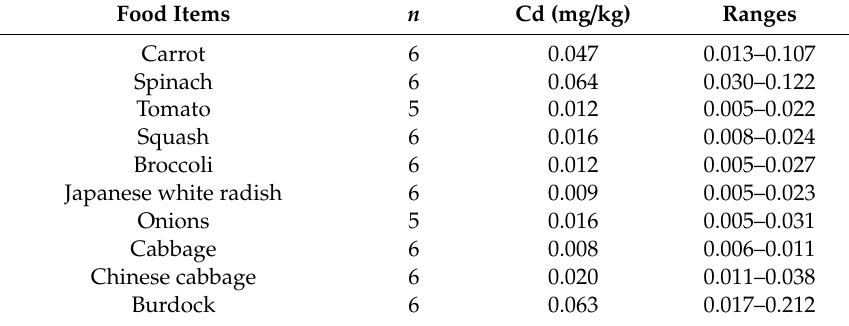
Table 4. Cadmium (Cd) concentrations in vegetables. Data are presented as arithmetic